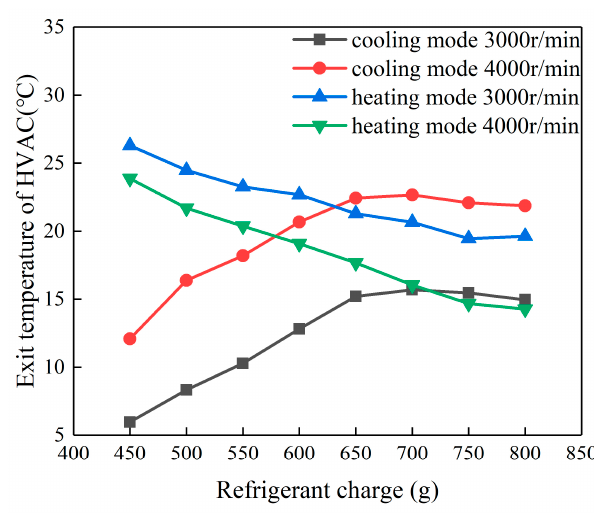
Figure 7. Exit temperature variations of heating, ventilation and air-conditioning (HVAC).